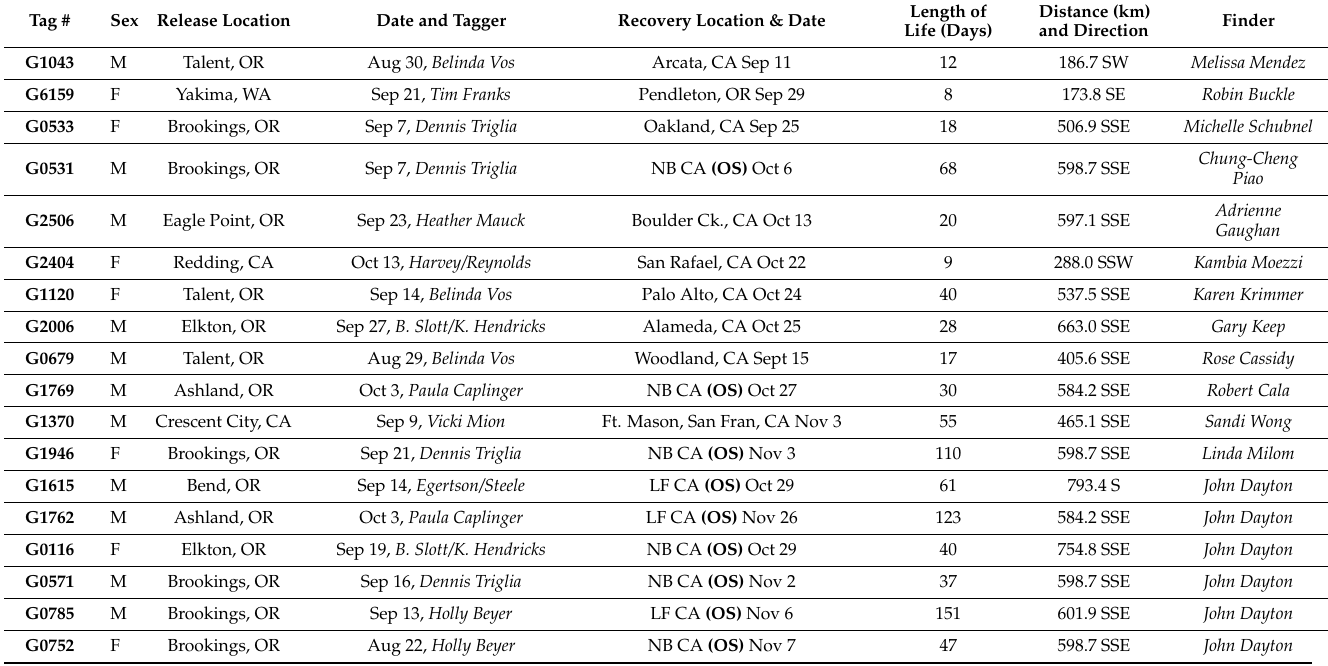
Table 4. Release, recovery, distance, direction and lifespan data for Monarchs captive-reared, tagged and released in the PNW during 2019. OS = overwintering site. Santa Cruz overwintering sites: LF = Lighthouse Field State Beach, NB = Natural Bridges State Beach, ML = Moran